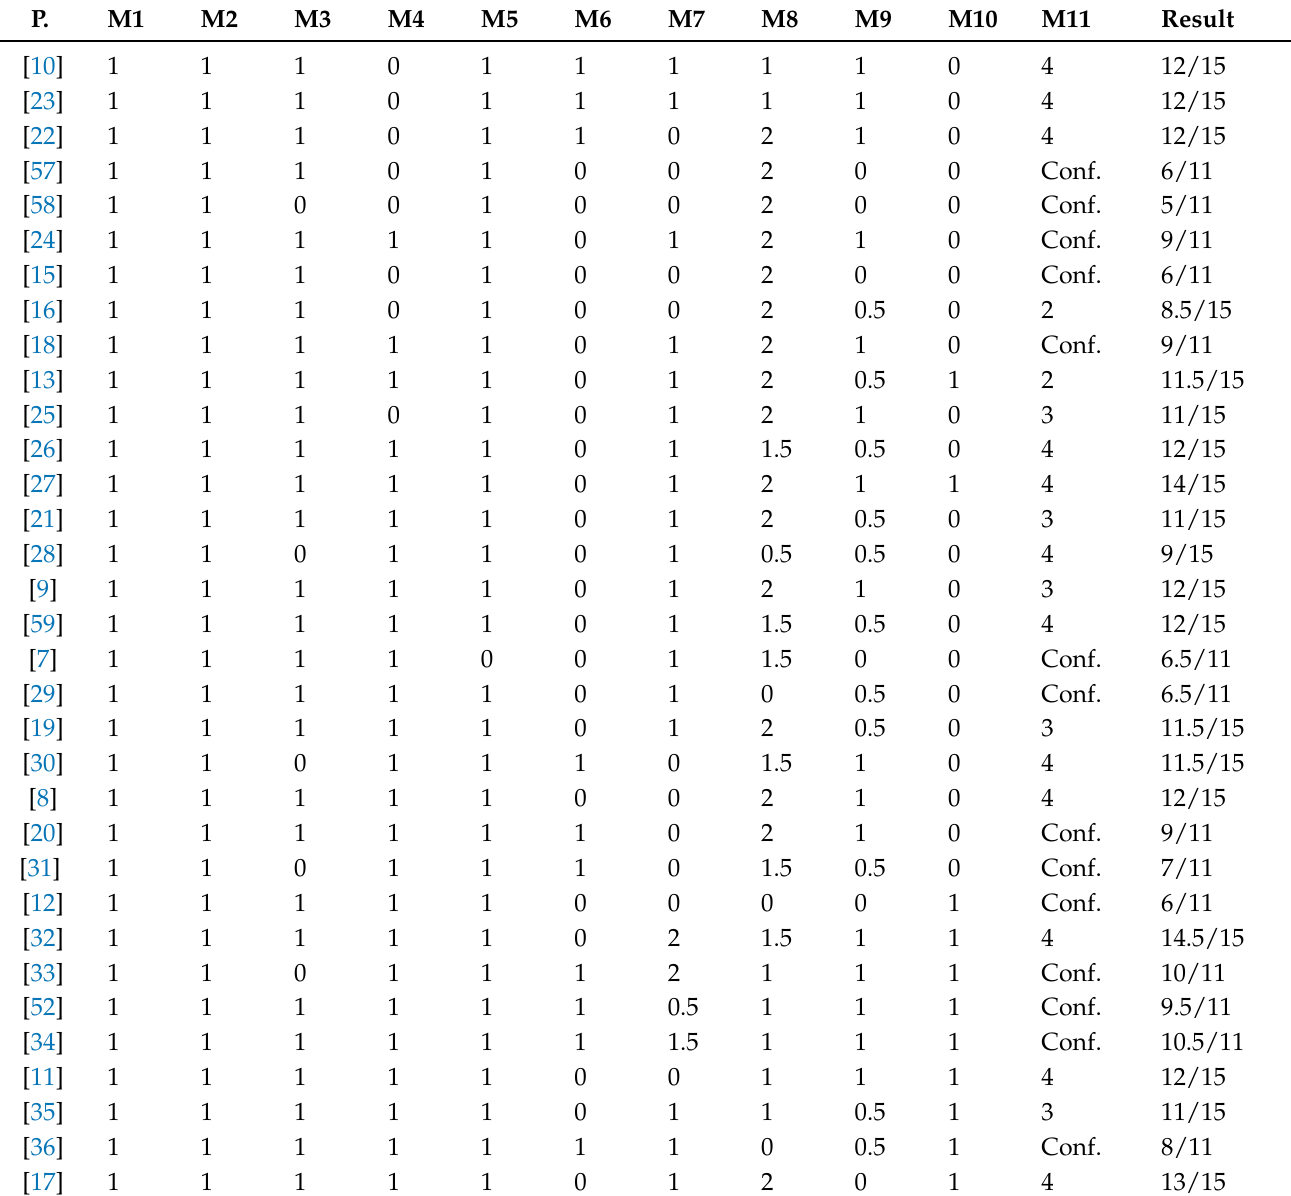
Table A2. Results of the application of the eligibility criteria to the filtered